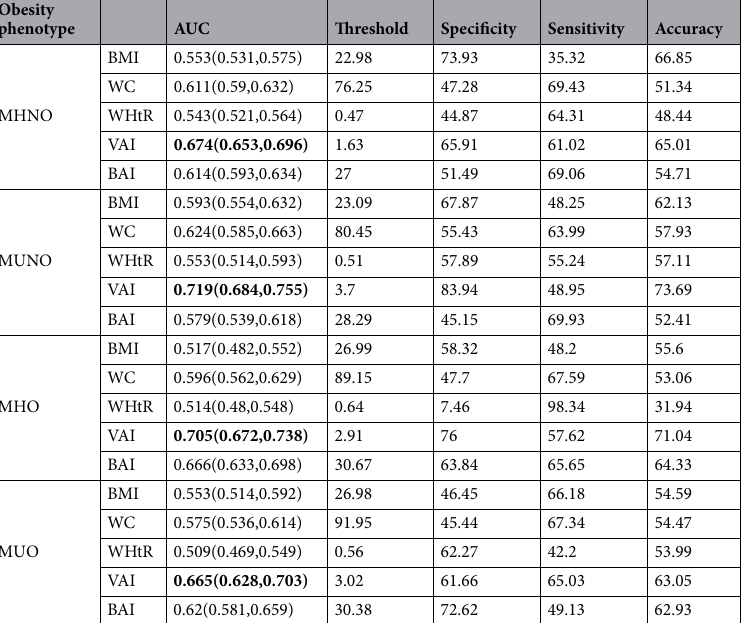
Table 3. Areas under the receiver operating characteristic curve (AUC) for identifying hyperuricemia risk with various adiposity measures within four metabolic health and obesity phenotypes defined by HOMA criteria. Abbreviations : HOMA, homeostasis model assessment of insulin resistance; MHNO, metabolically healthy non-obese; MUNO, metabolically unhealthy non-obese; MHO, metabolically healthy obese; and MUO,